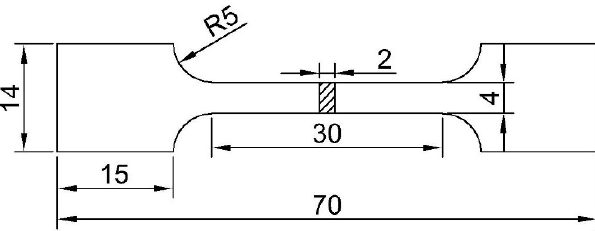
Figure 2. The size of tensile specimen